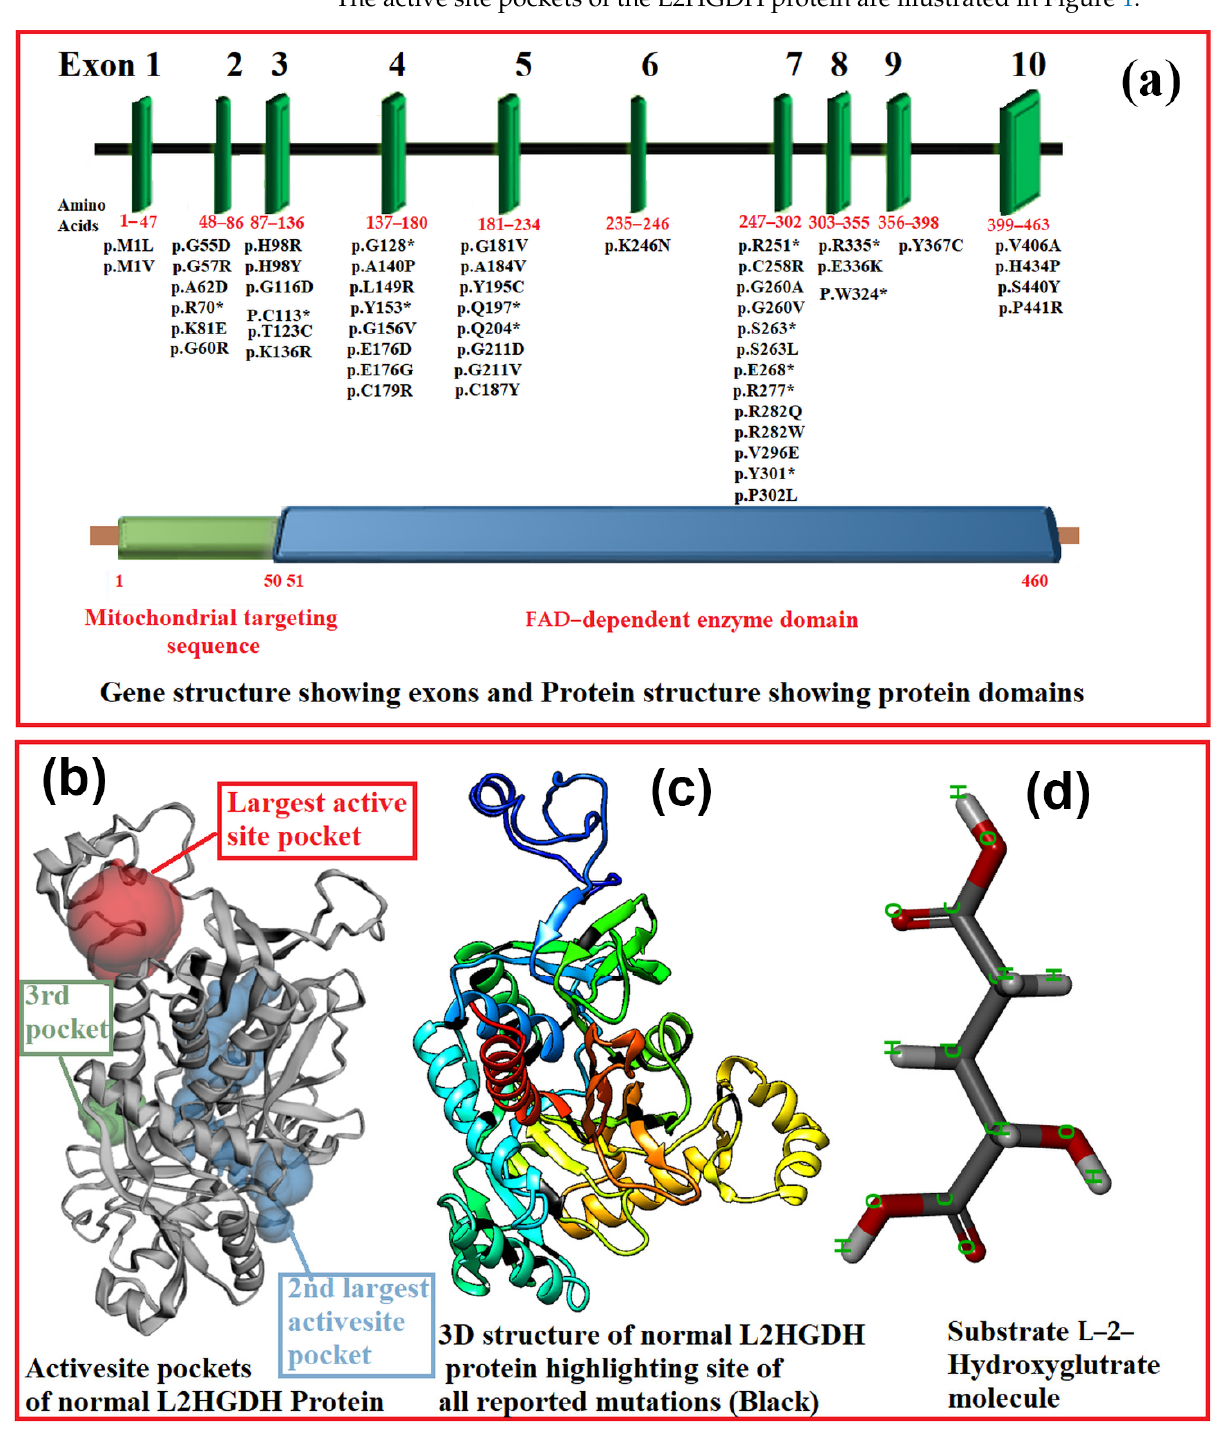
Figure 1. ( a ) L2HGDH gene and the positions of the mutations of respective exon and L2HGDH protein structures. ( b ) A 3D model of wild-type L2HGDH protein and its active site pockets. ( c ) The 3D structure of normal L2GHDH protein and the sites of all reported mutations in black. ( d ) L2HGDH substrate of